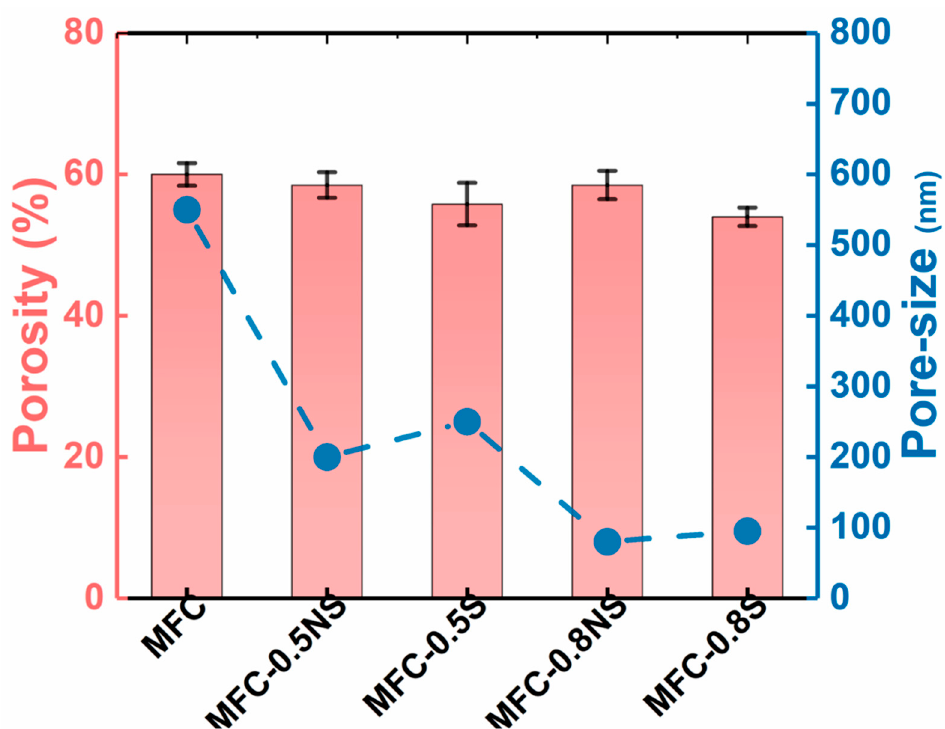
Figure 7. Porosity and pore size determination of MFC-NS and MFC-S membranes with varying silica NP concentrations.